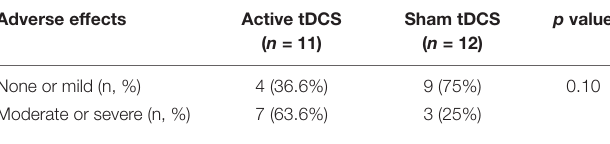
TABLE 5 | Adverse effects (AE) to tDCS reported by active or sham tDCS groups. Adverse